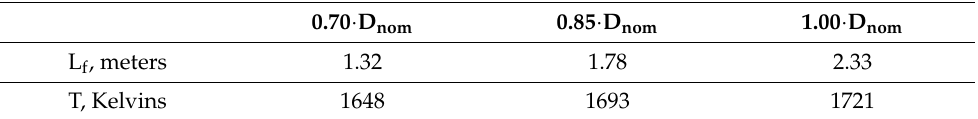
Figure 12. Results of the new mathematical modeling application. (calculation 1 according to Table 1). Table 1. Measurements of the torch length and temperature during